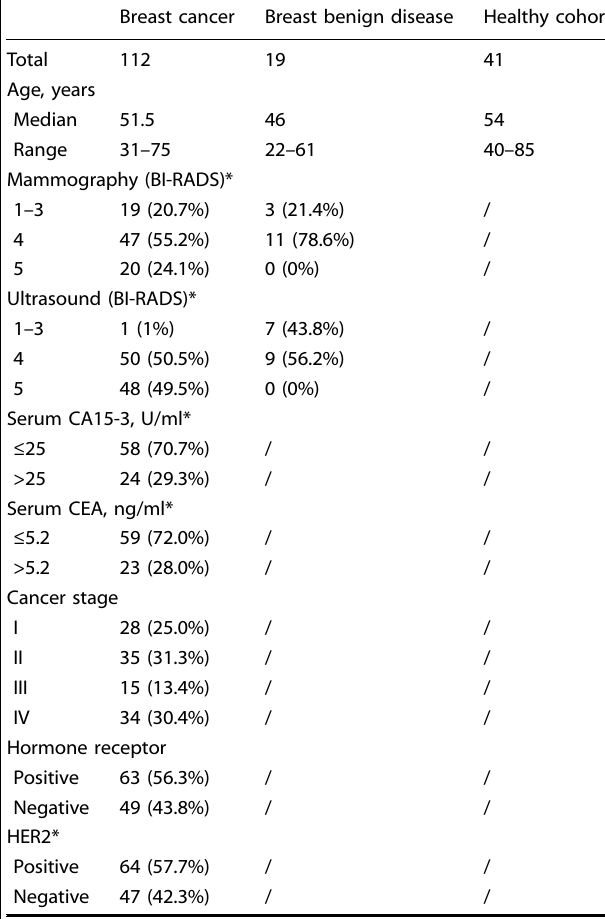
Abbreviations: BI-RADS breast imaging reporting and data system, CA15-3 carbohydrate antigen 15-3, CEA carcino-embryonic antigen, HER2 human epidermal growth factor receptor 2. *Excluded the unknown